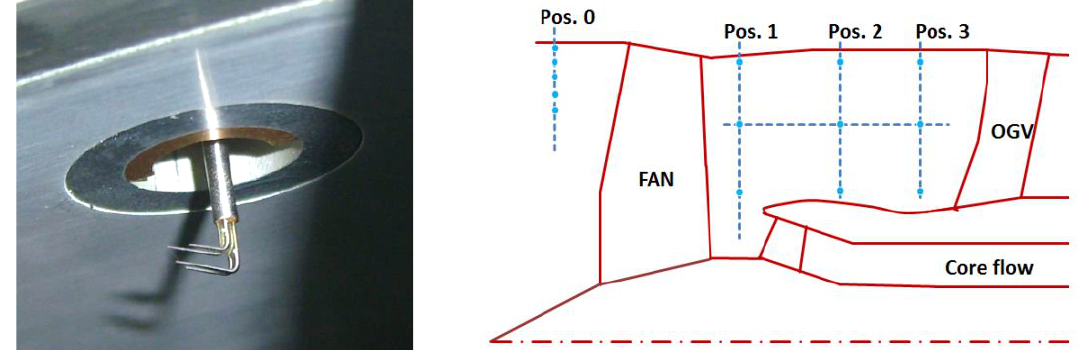
Figure 10. ( Left ) Photograph of the two velocity components (u,v) hot-wire probe. ( Right ) UFFA test rig cross section [16]. Measurements were performed at the radial line “Pos. 0” in the fan inflow